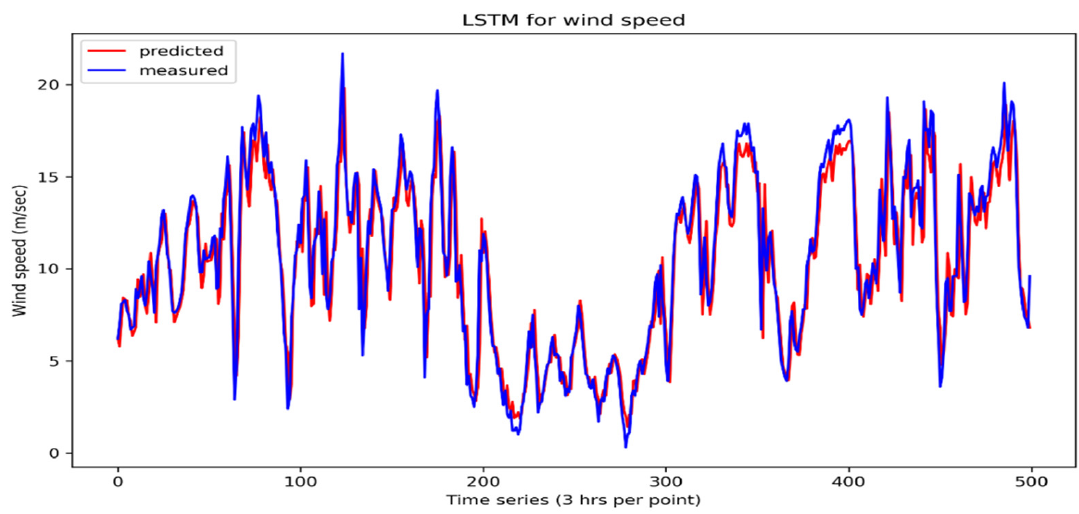
Figure 9. LSTM wind speed prediction.